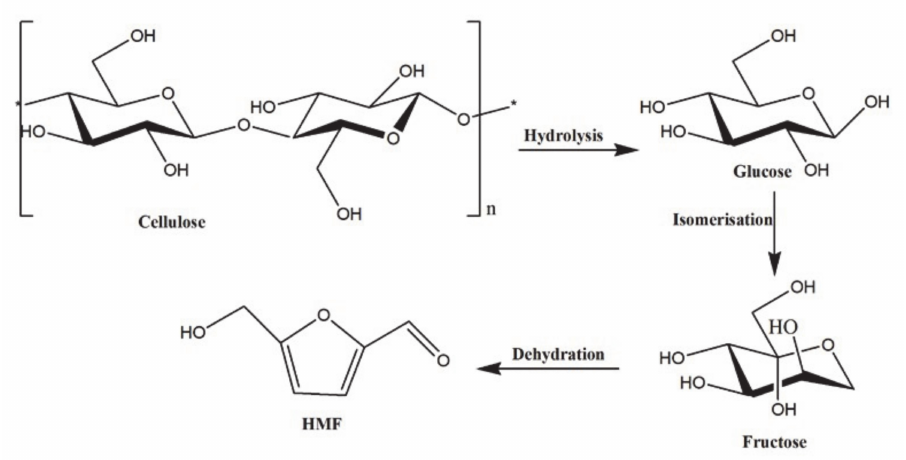
Figure 5. Synthesis of hydroxymethylfurfural (HMF) from